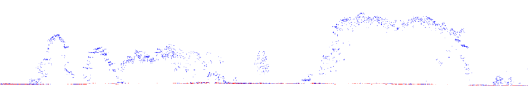
Figure 15. Example of Leica SPL100 vegetation penetration.